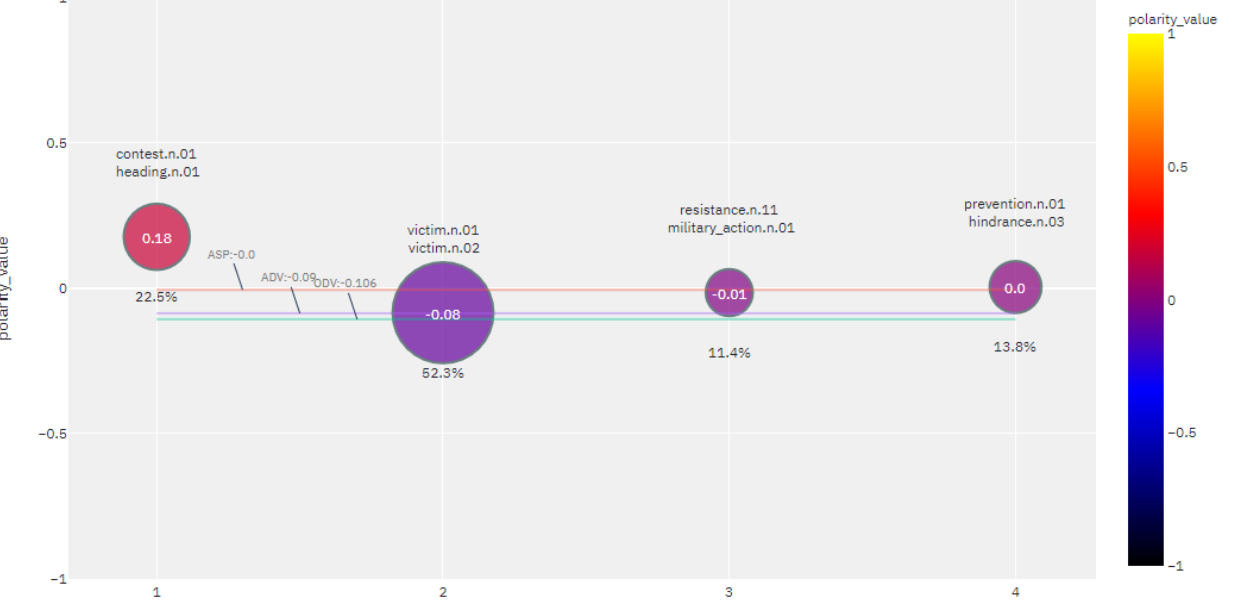
Figure 6. Sentiment potential ( SP ) of lexeme borba (eng. fight-n ) calculated with SenticNet 6 polarity-value; propagated on pruned graph clusters of 15 best ranked collocates in the first degree and 15 collocates in the second degree within hrwac22